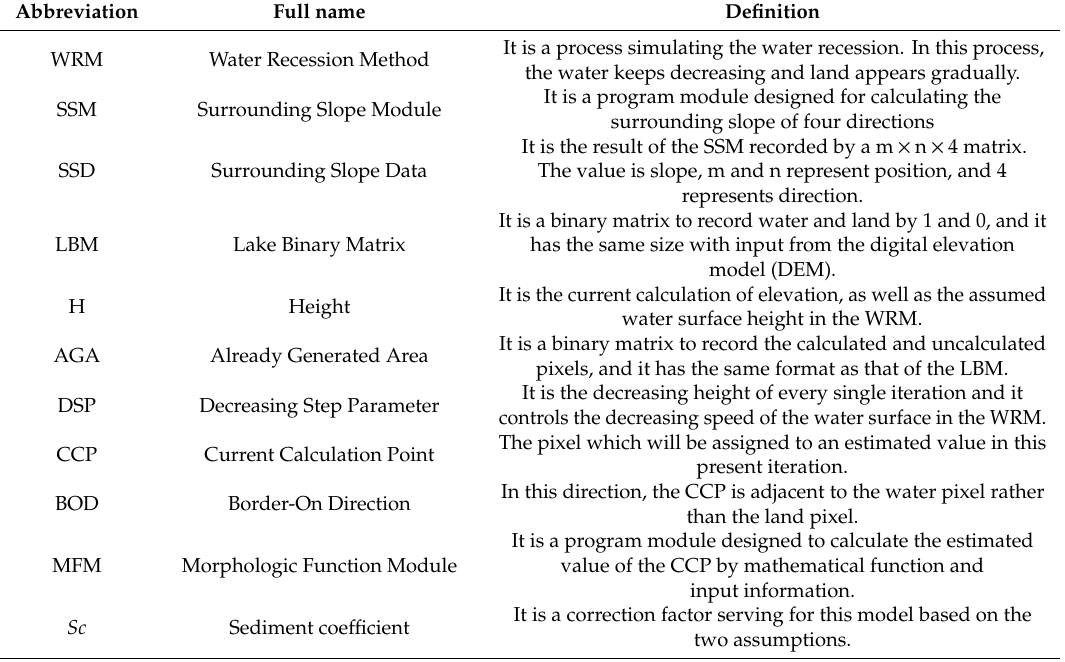
Table 1. The full name / meaning of the abbreviations in the model